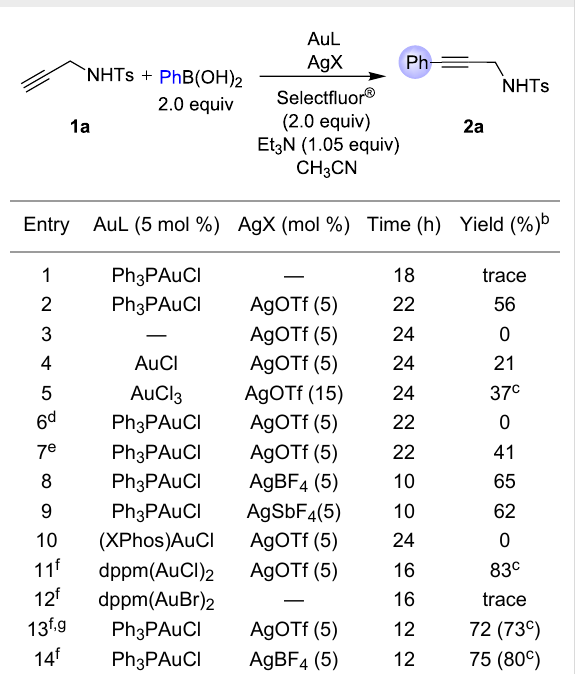
Table 1: Initial screenings of Au(I)/Au(III)-catalyzed Sonogashira coupling a